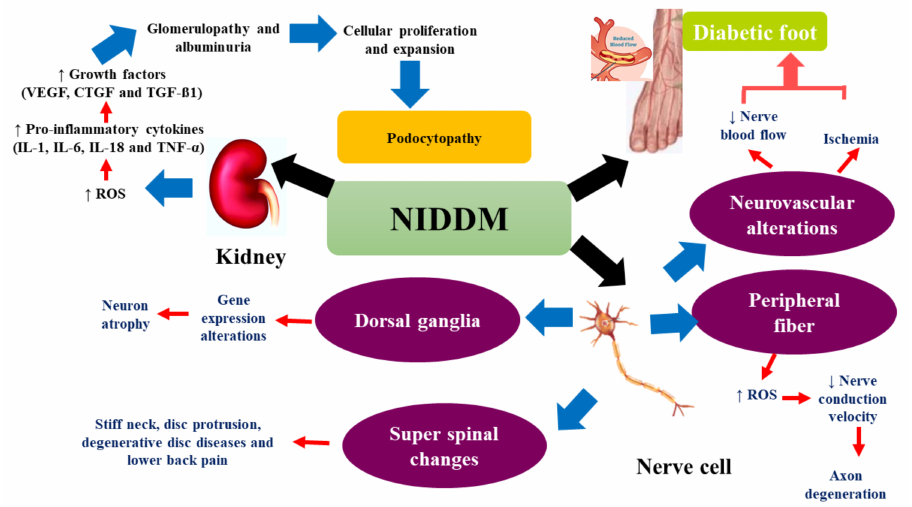
Figure 3. Effect of noninsulin-dependent diabetes mellitus (NIDDM) on kidney, nerve cell, and foot. VEGF: vascular endothelial growth factor, CTGF: connective tissue growth factor, TGF- β 1: transforming growth factor-beta 1, IL-1: interleukin-1, IL-6: interleukin-6, IL-18: interleukin-18, TNF- α : tumor necrosis factor-alpha, ROS: reactive oxygen